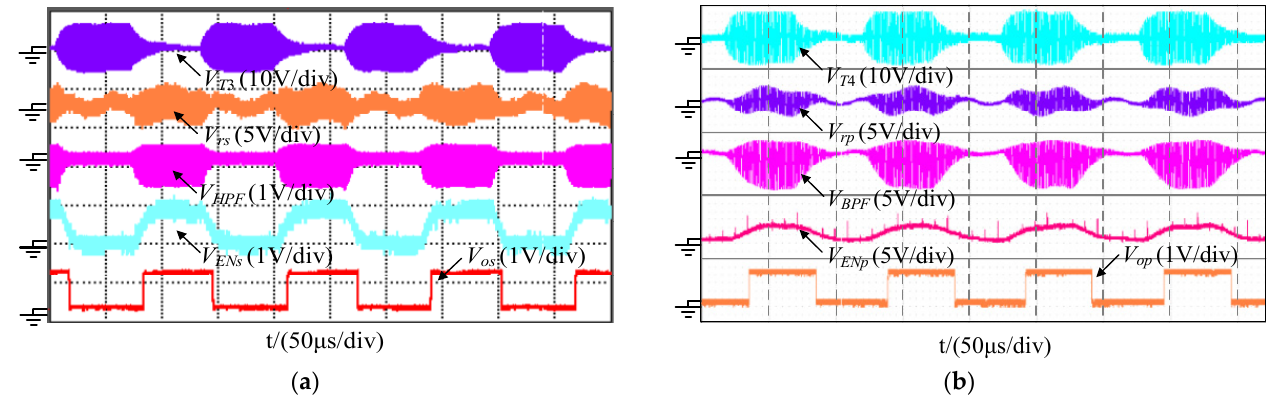
Figure 16. The forward and backward information transfer with power transfer. ( a ) Only forward information transfer. ( b ) Only backward information transfer.